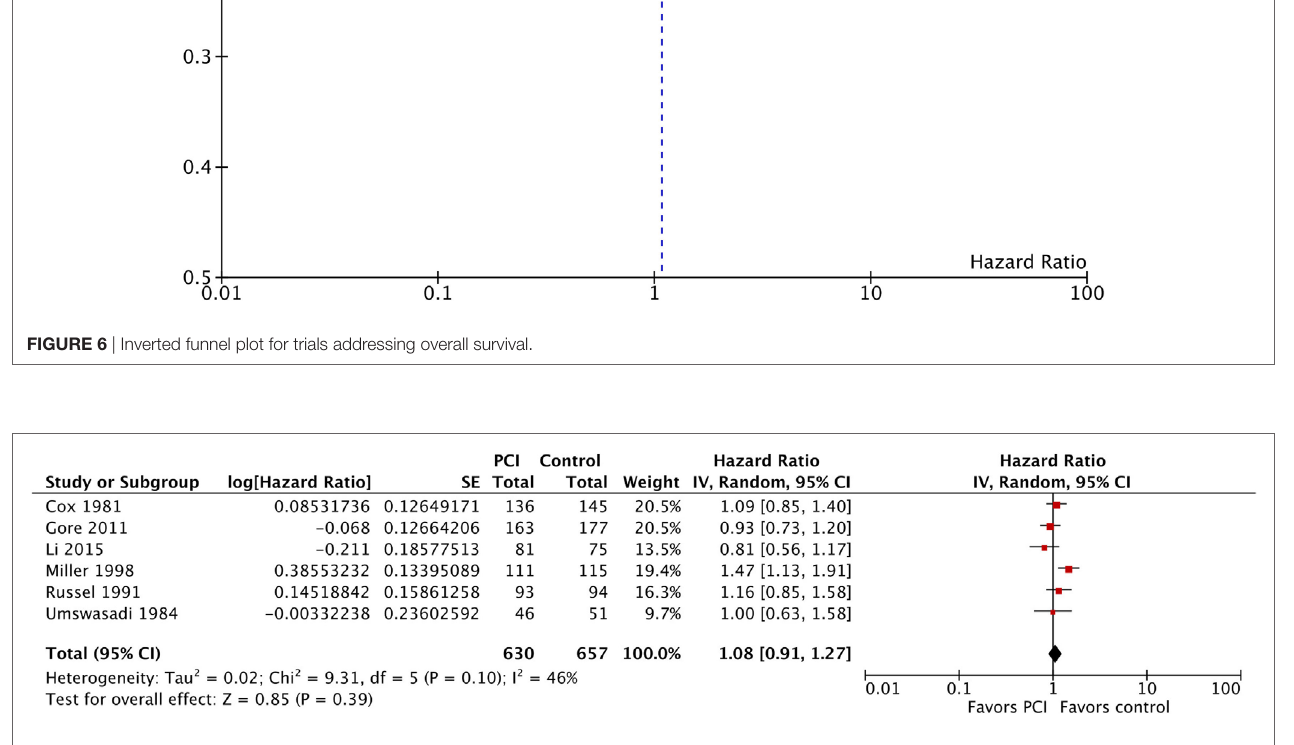
FigURe 7 | Sensitivity analysis: Effect of PCI on overall survival in 1,287 patients with non-small-cell lung cancer from six trials (Umsawasdi et al. added). Abbreviations: PCI, prophylactic cranial irradiation; CI, confidence